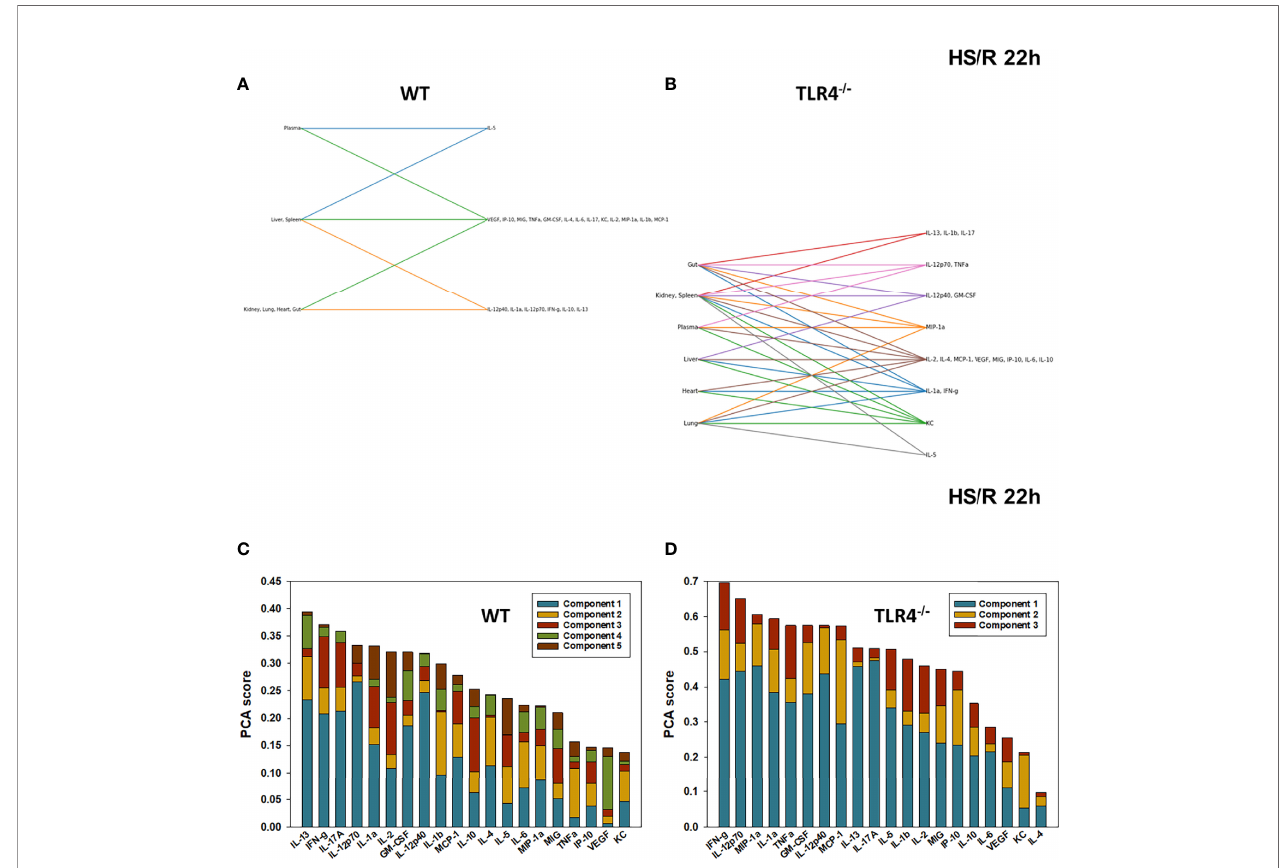
FIGURE 7 | Hypergraphs and Principal Component Analysis of in fl ammatory mediators from WT and TLR4 -/- mice subjected to HS/R (22h). Plasma and tissue samples from heart, lung, liver, gut, spleen, and kidney were collected from WT and TLR4 -/- mice subjected to HS/R (22h) and analyzed using Luminex ™ as described in Materials and Methods. Panels (A, B) show the hypergraphs and Panels (C, D) show the PCA results (70% variance) in WT and TLR4 -/- mice,